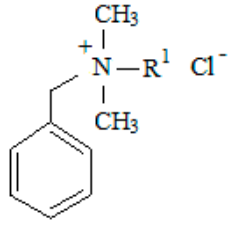
Figure 8. Structural formula of the studied surfactants. Table 4. Characteristics of studied alkylbenzyldimethylammonium chloride.